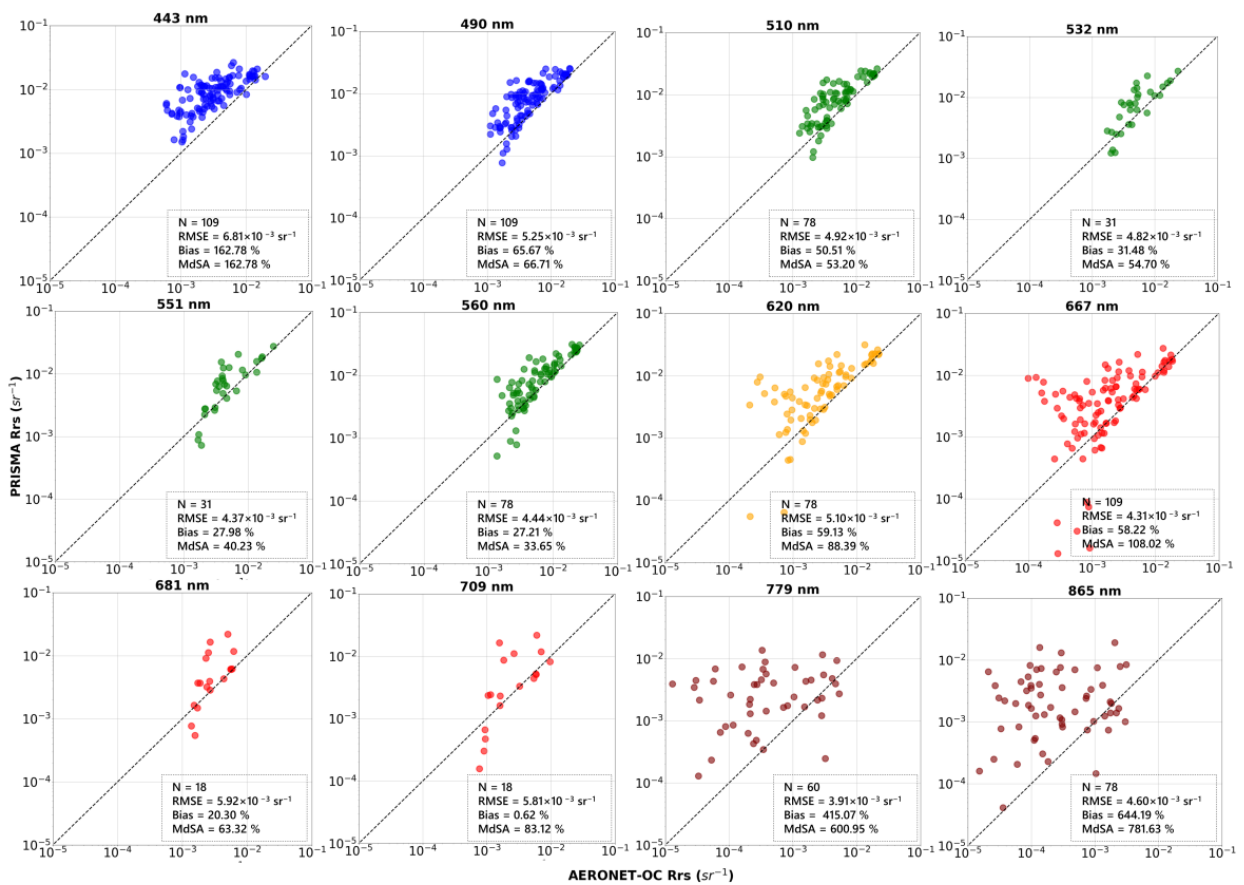
Figure 4. Scatterplots between in situ and PRISMA L2d Rrs measurements, for each of the 12 bands considered (x-axis shows in situ data while the y-axis shows PRISMA L2d data). n represents the sample size. Scatterplots are shown in log-log scale and the dashed black line refers to the 1:1 line. In Figure 5, the spectral residuals of the entire dataset are presented in order to highlight where there is less deviation between the satellite data and the in situ measurements: residuals are expressed in terms of Rrs difference (residuals = Rrs PRISMA L2d − Rrs AERONET-OC ) [41]. Referring to the mean and median (continuous and dashed line, respectively), the residual values are slightly higher in the blue and in the red spectral regions (especially when examining the mean line). Furthermore, the graph shows that usually when there is disagreement in the match-ups, it is due to an overestimation of the PRISMA Rrs spectrum compared to the in situ